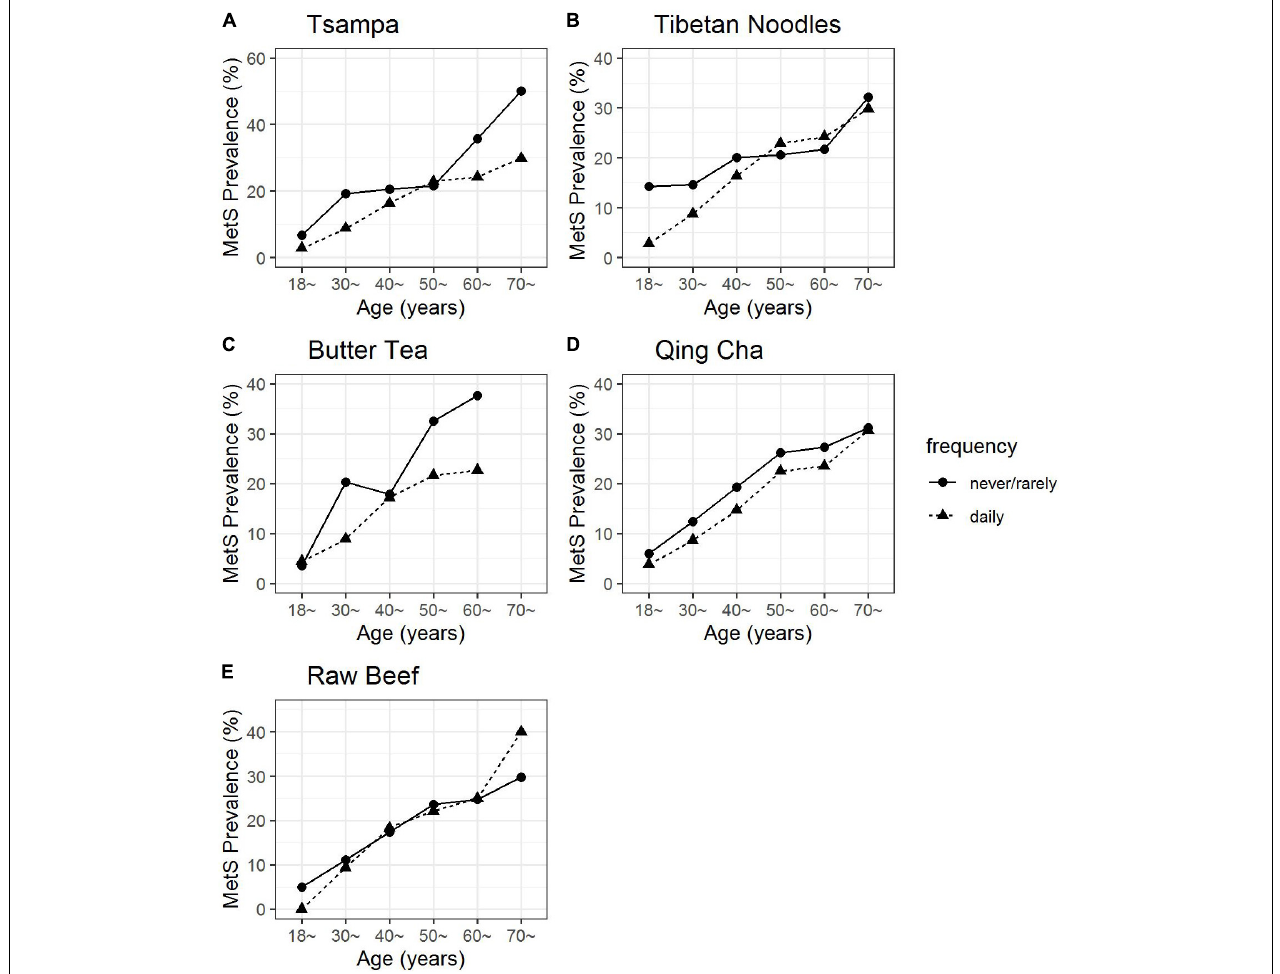
FIGURE 1 | The prevalence of MetS along with age by tsampa (A) , Tibetan noodles (B) , butter tea (C) , Qing cha (D) , and raw beef (E) intake frequency. There were a limited number of participants older than 70 years old who were consuming butter tea, thus this age group was not shown in panel (C) .